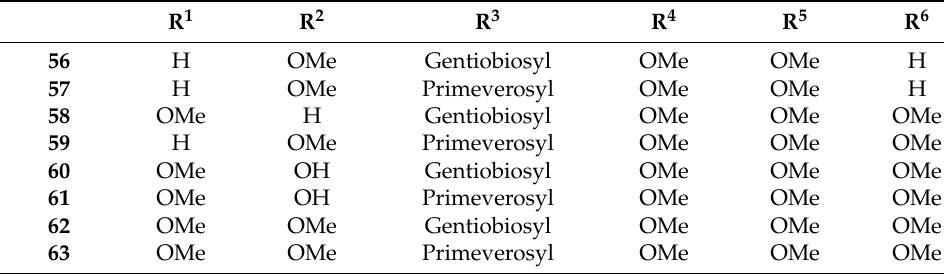
Table 2. The structure of compounds 56 – 63